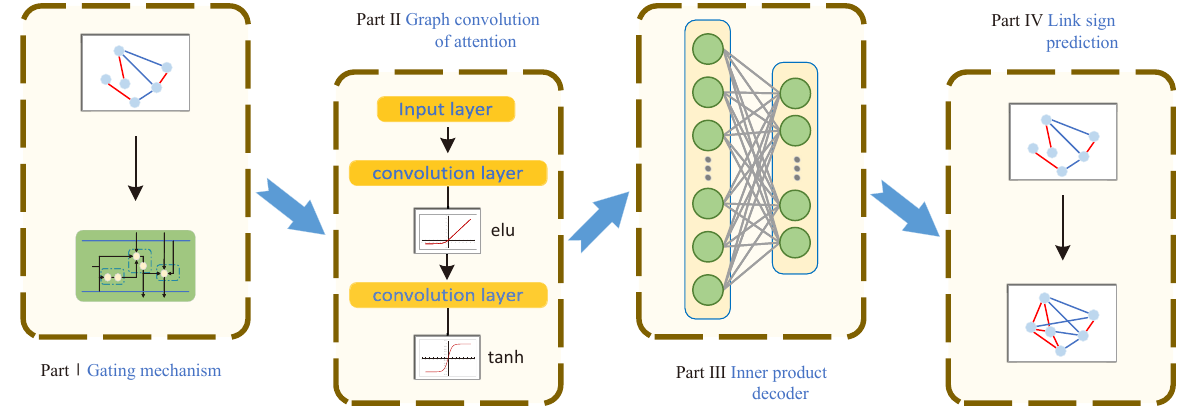
Figure 5. Framework of the proposed SN-GGAT model. Part I uses the gating mechanism to calculate the parameters required by the algorithm; part II executes the algorithm to obtain the feature representation of each node; part III uses the inner product decoder to obtain the reconstructed adjacency matrix; part IV uses the prediction result to verify the accuracy of the